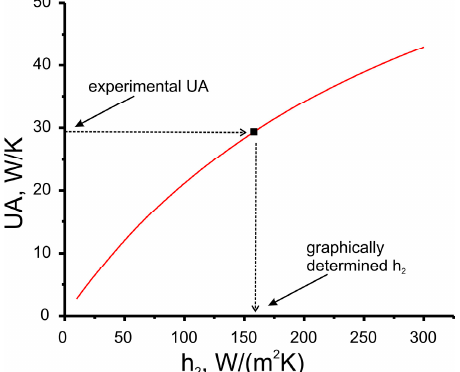
Figure A3. Dependence of global heat transfer coefficient UA of radiator R3 on heat transfer coefficient h 2 (red line) and element of experimental dataset (symbol). Arrows illustrate the principle of graphical solving of h 2 = function − 1 (UA).